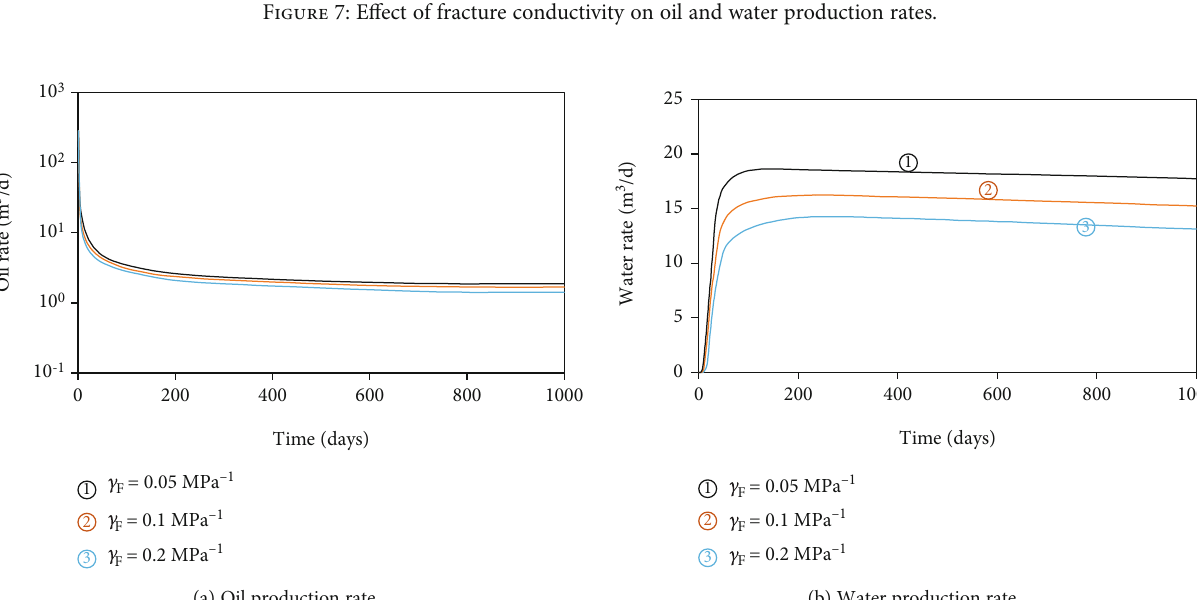
Table 1. The oil-water relative permeability curves in the hydraulic fracture system are shown in Figure 5.